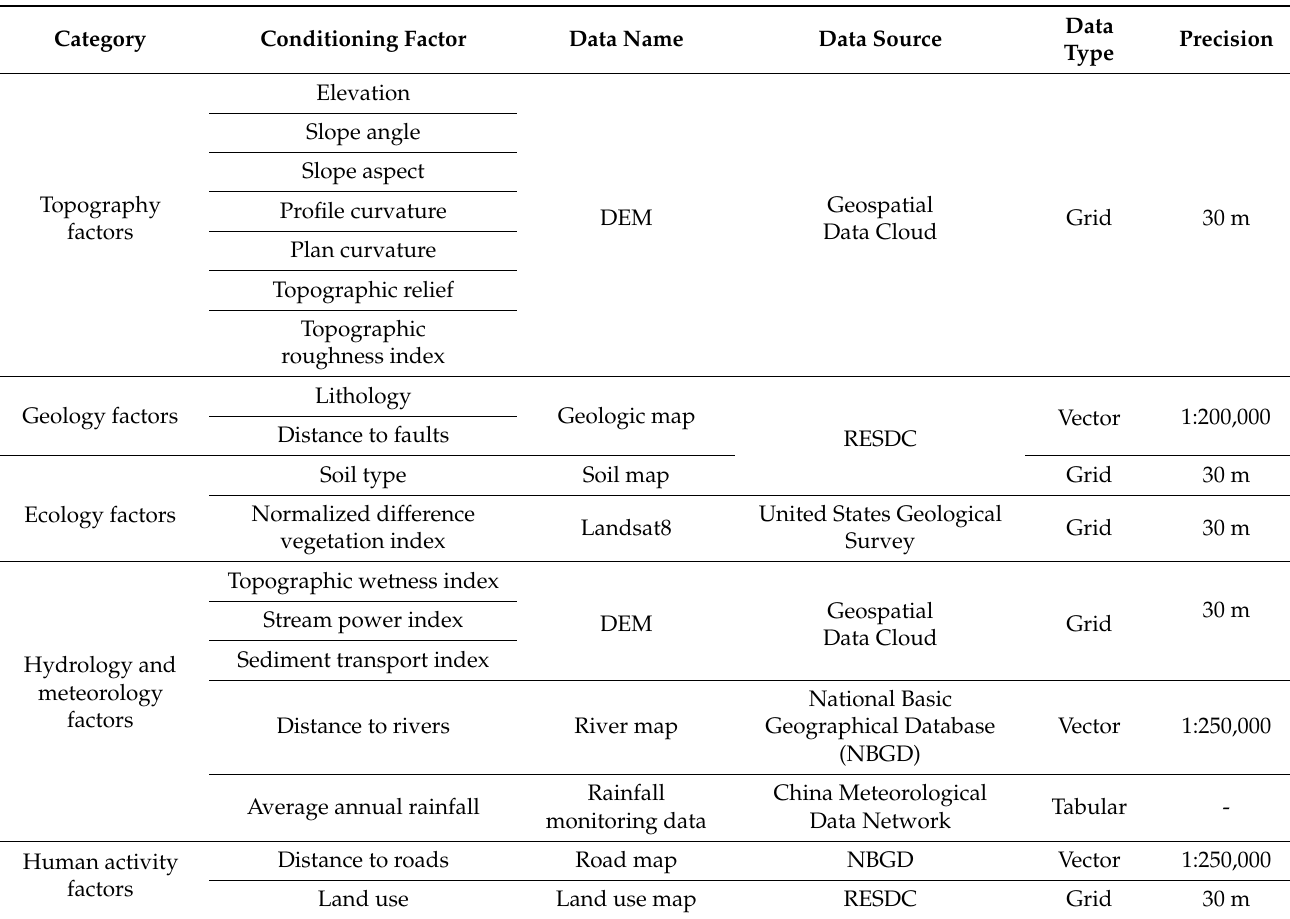
Table 2. The conditioning factors and their data